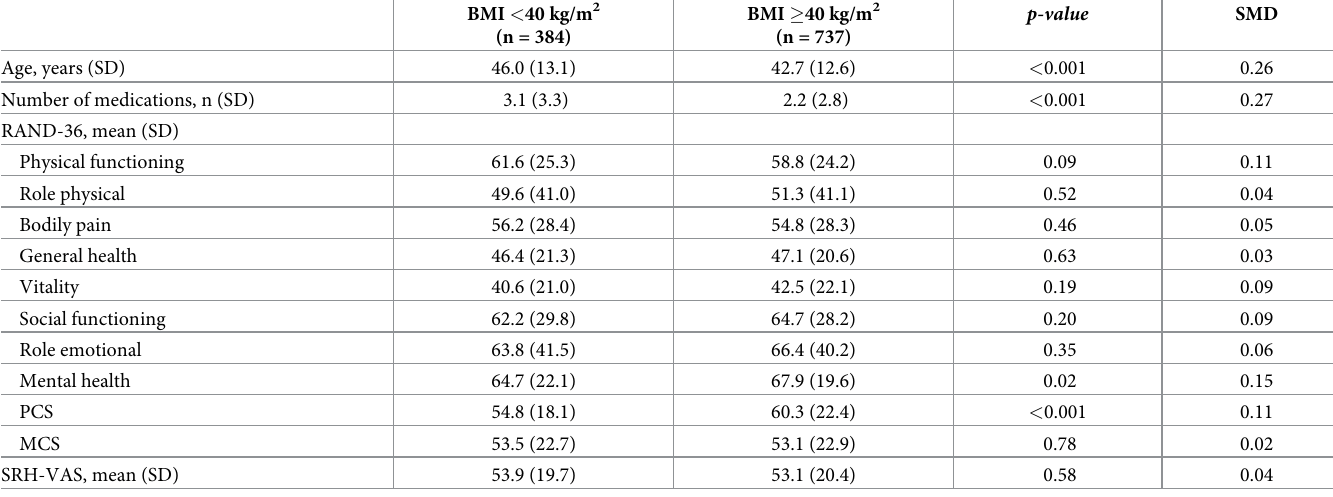
Table 3. Health-related quality of life (HRQoL) between two different BMI categories in the group with obesity (BASUN). Mean values are given for all RAND-36 scales and SRH-VAS, unless otherwise